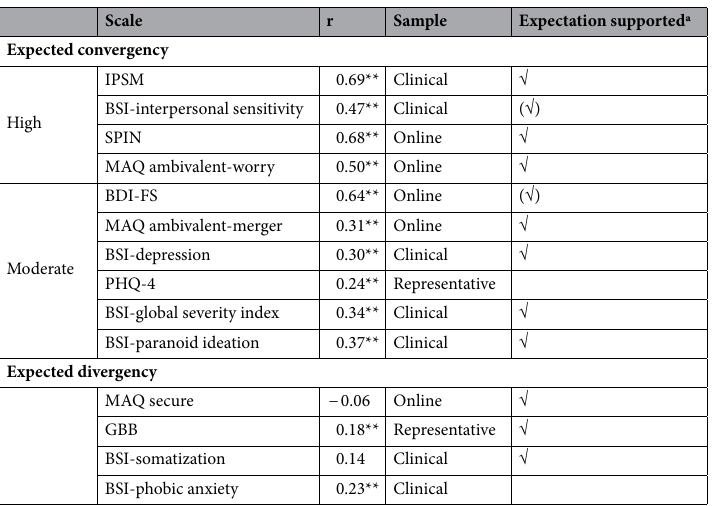
Table 2. Correlations of the 10-item SPQ with convergent and divergent measures. Spearman rank correlations are used because normality could not be assumed for most measures. IPSM interpersonal sensitivity measure, BSI brief symptom inventory, MAQ measure of attachment qualities, SPIN social phobia inventory, BDI-FS becks depression inventory—fast screen, PHQ-4 patient health questionnaire-4. ªWe expected highly convergent measures to show correlations ≥ 0.50 and moderately convergent measures ≥ 0.30. whereas divergent measures to show correlations ≤ 0.20. **p < 0.001; *p < 0.05.